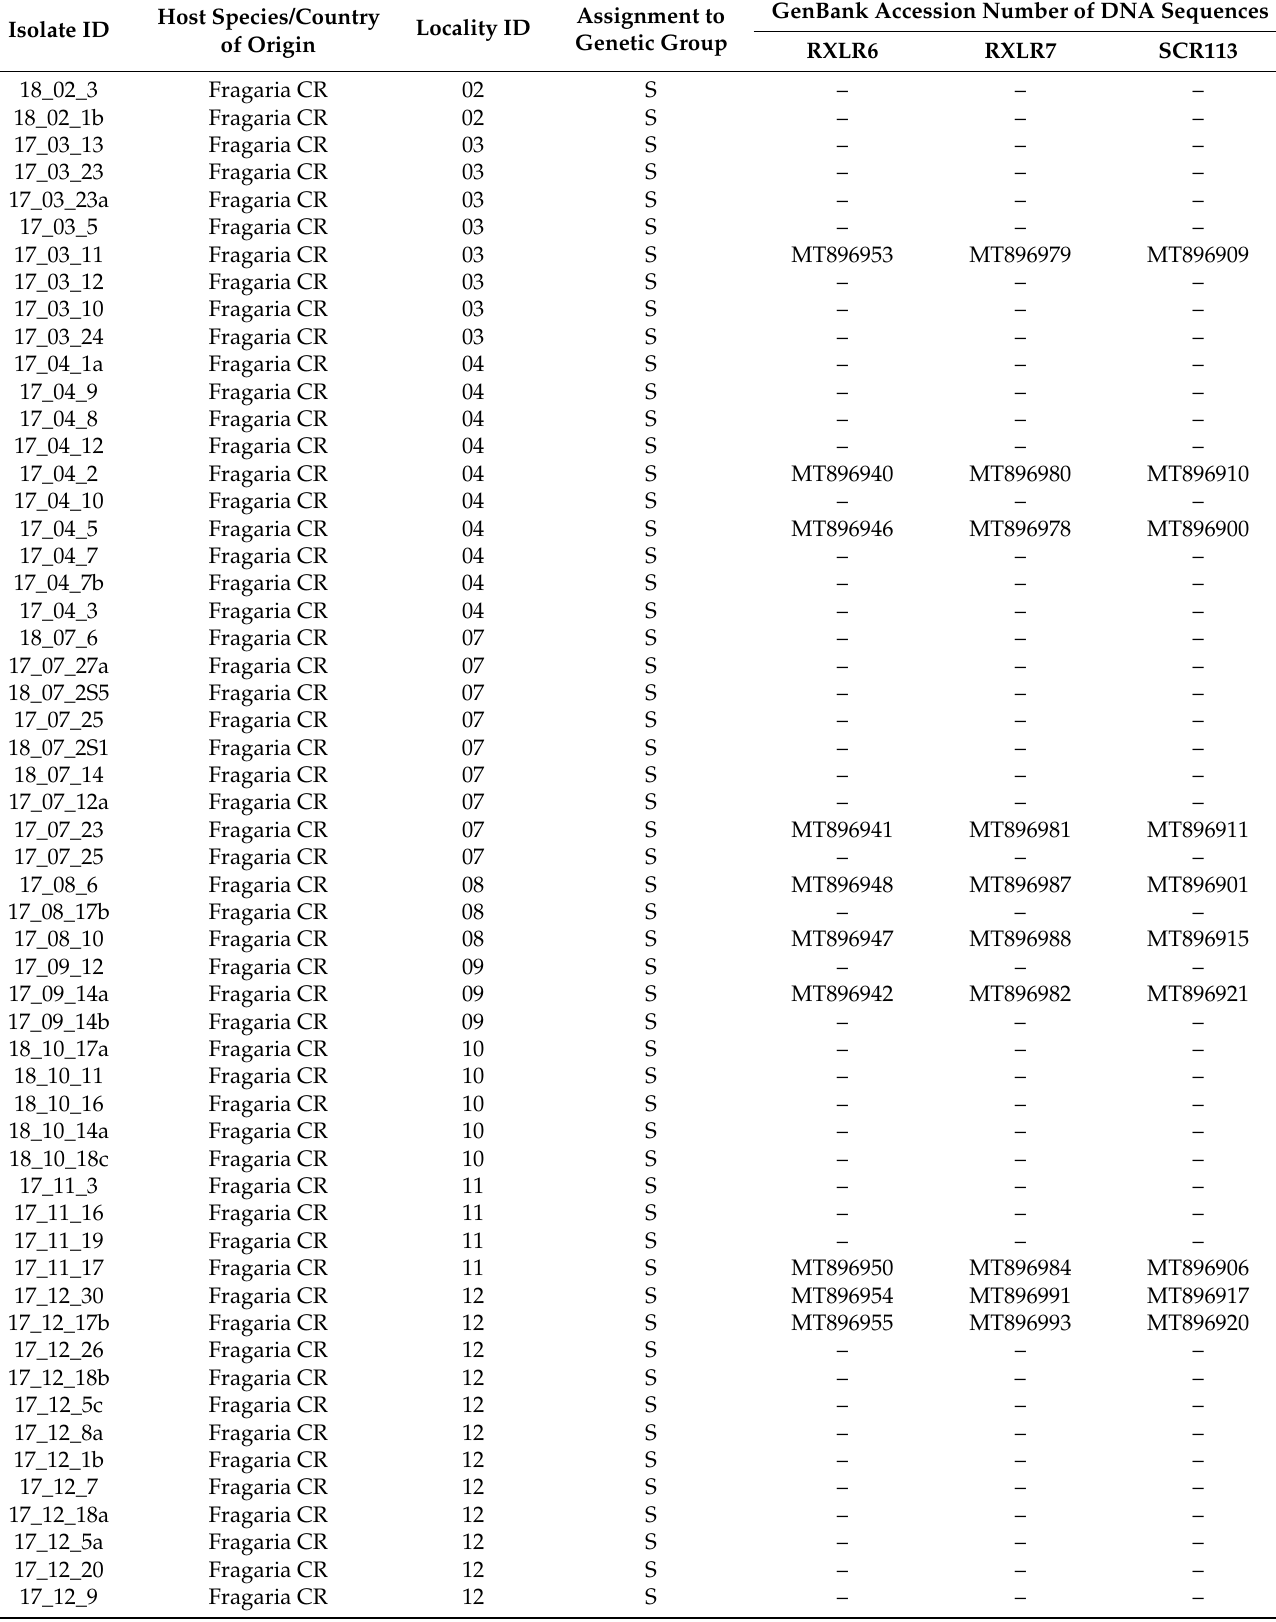
Table 1. List of isolates used in the